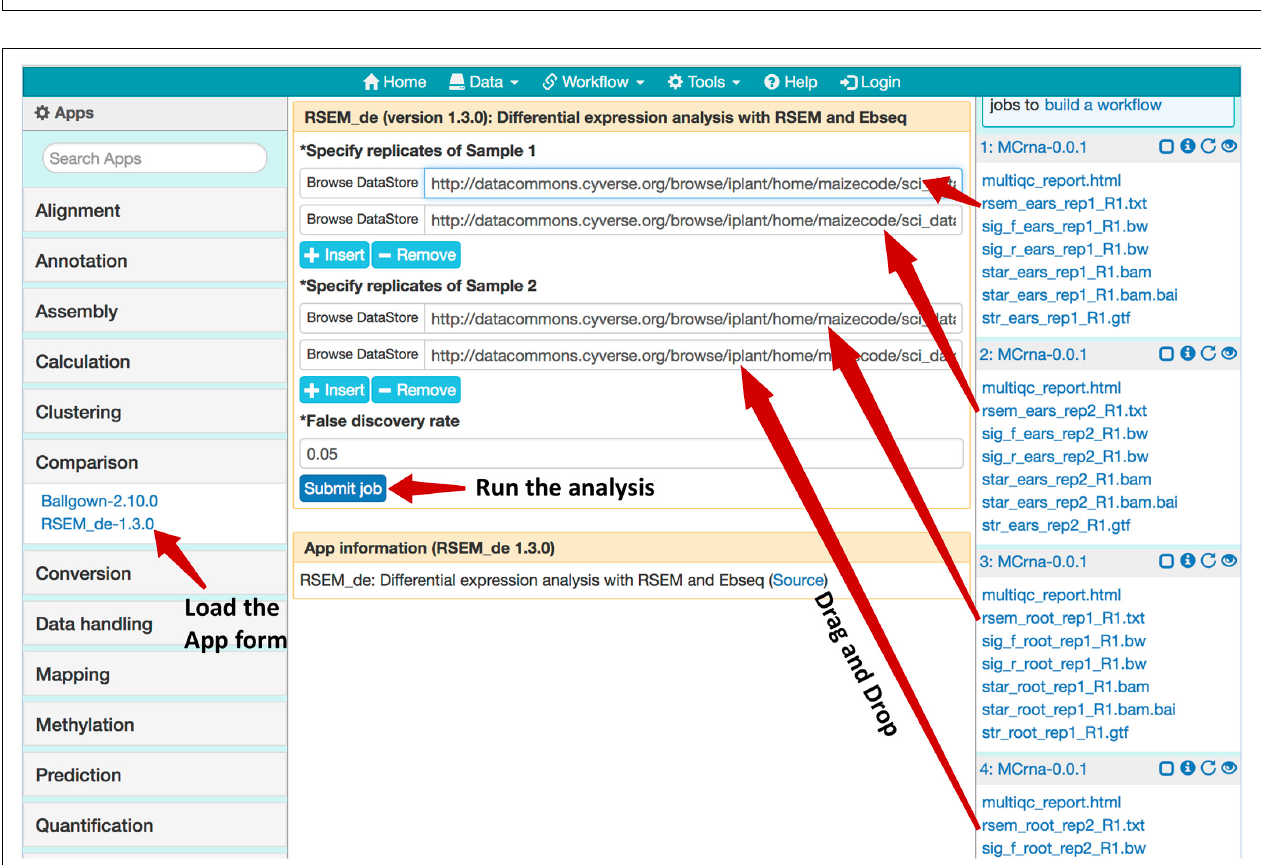
FIGURE 4 | MaizeCODE MCrna app for processing RNA-Seq data from two replicates. The MCrna app wraps six tools, FastQC, bbduk, MultiQC, STAR, RSEM, and StringTie, together for QC and quantification of each replicate.